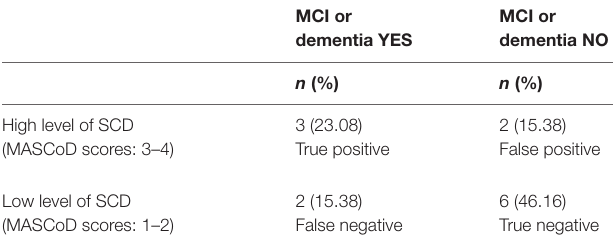
TABLE 2 | Contingency table comparing SCD and neuropsychological assessment ( n =